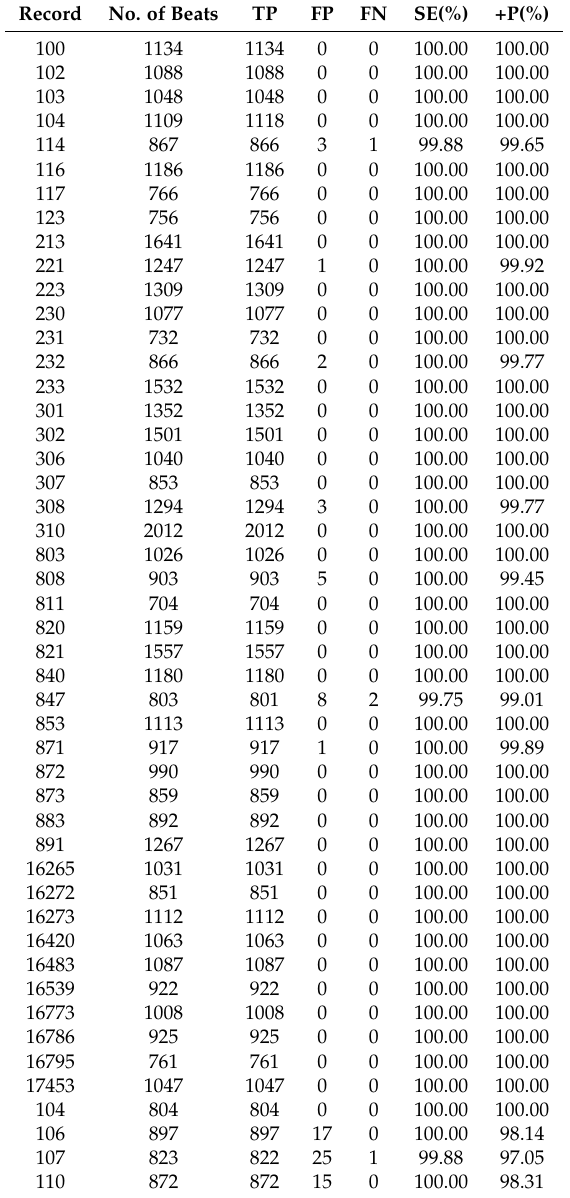
Table 5. Performance of Method III using K = 60 Hz on the QT Database. The TP stands for true positives (the number of QRS complexes detected as QRS complexes), FN stands for false negatives (the number of QRS complexes that have not been detected), FP stands for the number of false positives (non-QRS complexes detected as QRS complexes), SE stands for sensitivity, and + P stands for positive